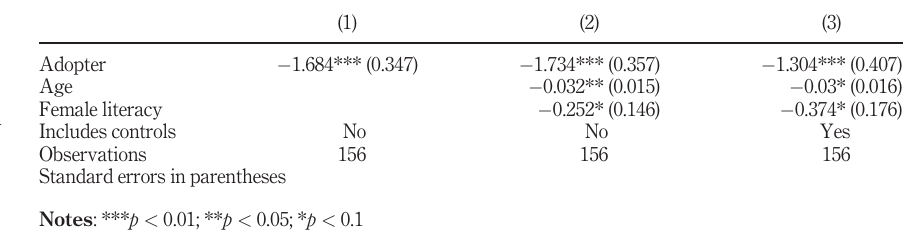
Table 3. Logistic regression estimates for impact of CSAPs adoption, female literacy and migration on reduction